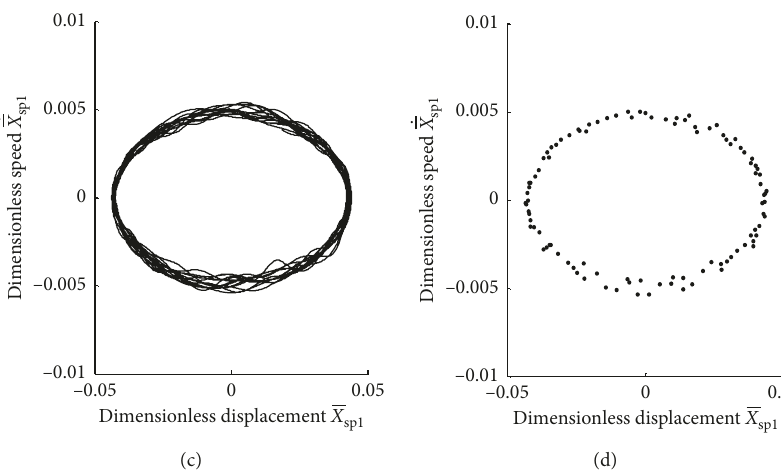
Figure 11: Process diagrams of response, phase diagram, and Poincar´e section under b process diagram of displacement response. (b) Time process diagram of meshing force response. (c) Phase diagram. (d) Poincar´e section.